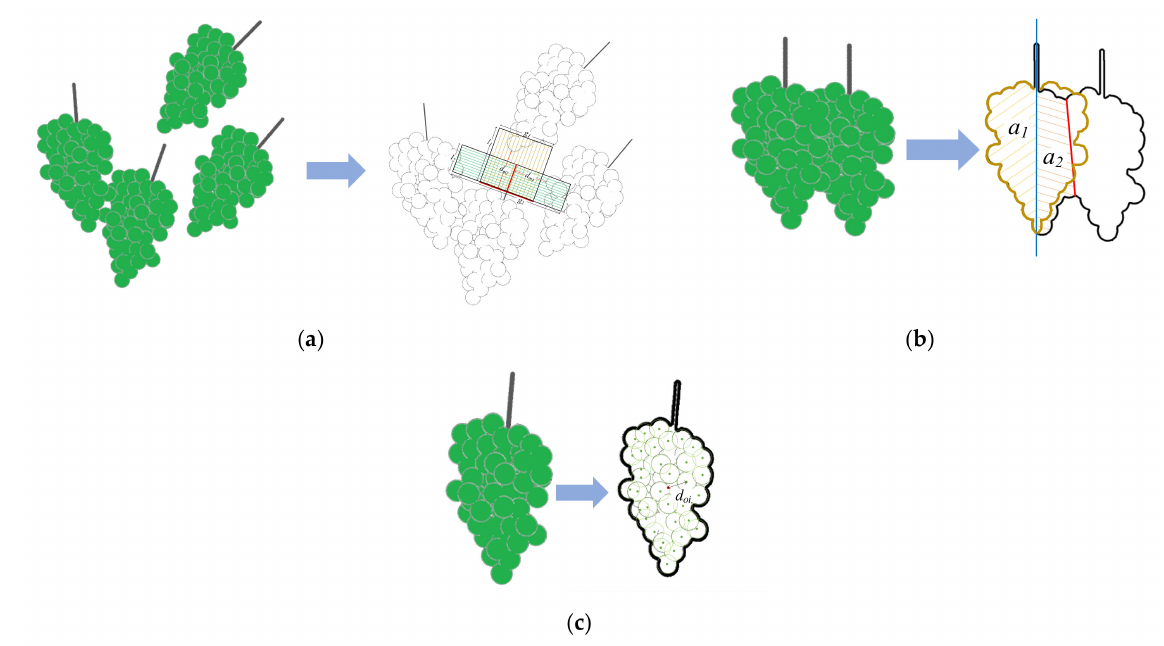
Figure 8. Factor calculation. ( a ) Grasping position constraints; ( b ) cluster occlusion; ( c ) cluster compactness.